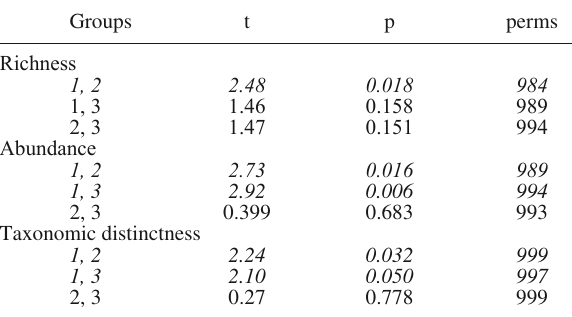
Table 3. – Pairwise test for level of bed density. Levels of density are denoted by 1, low density; 2, medium density; 3, high density. Italics denote significant